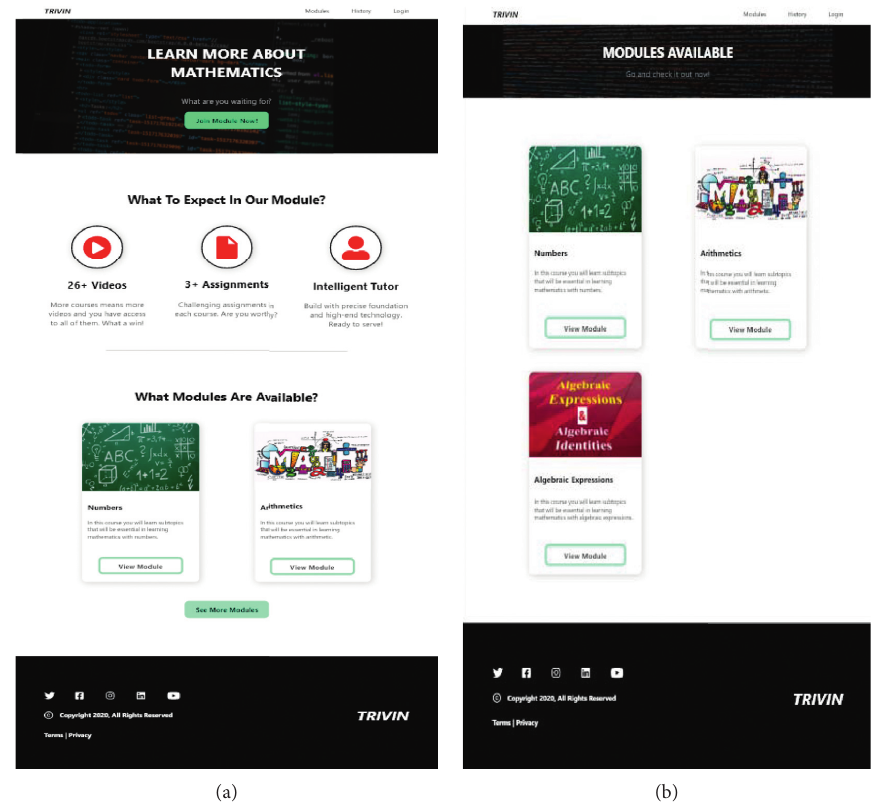
Figure 4: (a) Home page user interface and (b) module page user